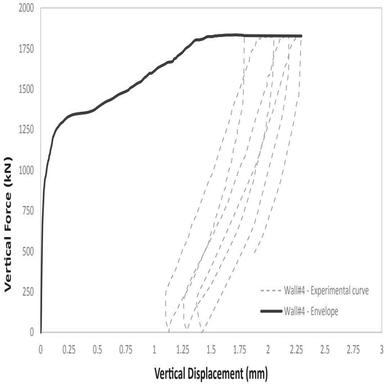
Force - Displacement (kN - mm) diagram with envelope curve for Wall#4 subjected to load-bearing test.